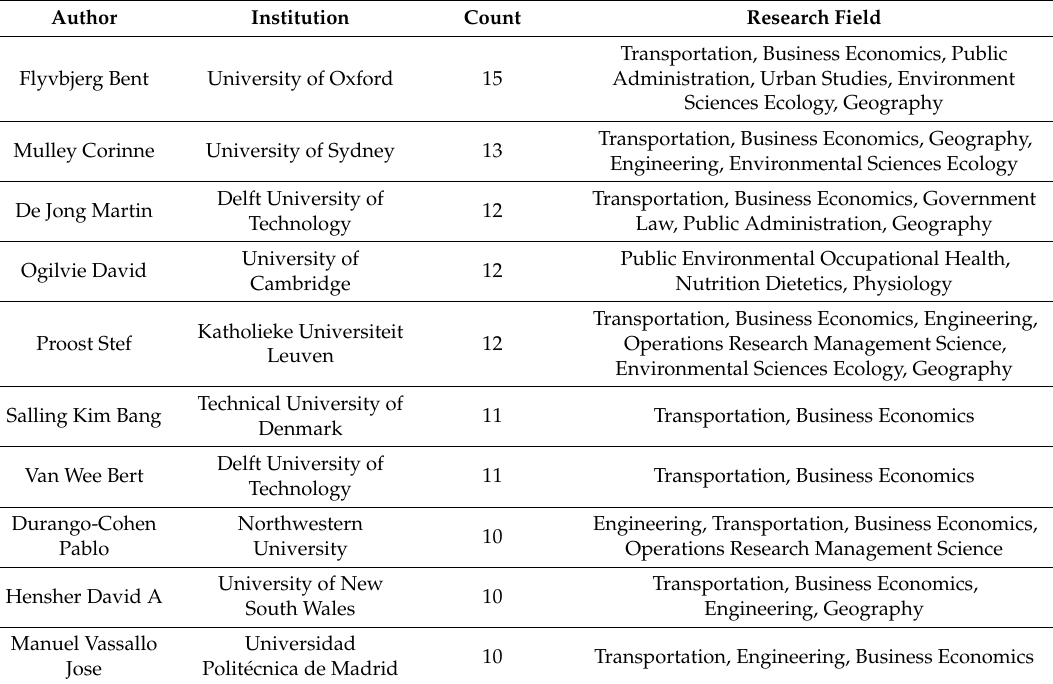
Table 2. Top ten most productive